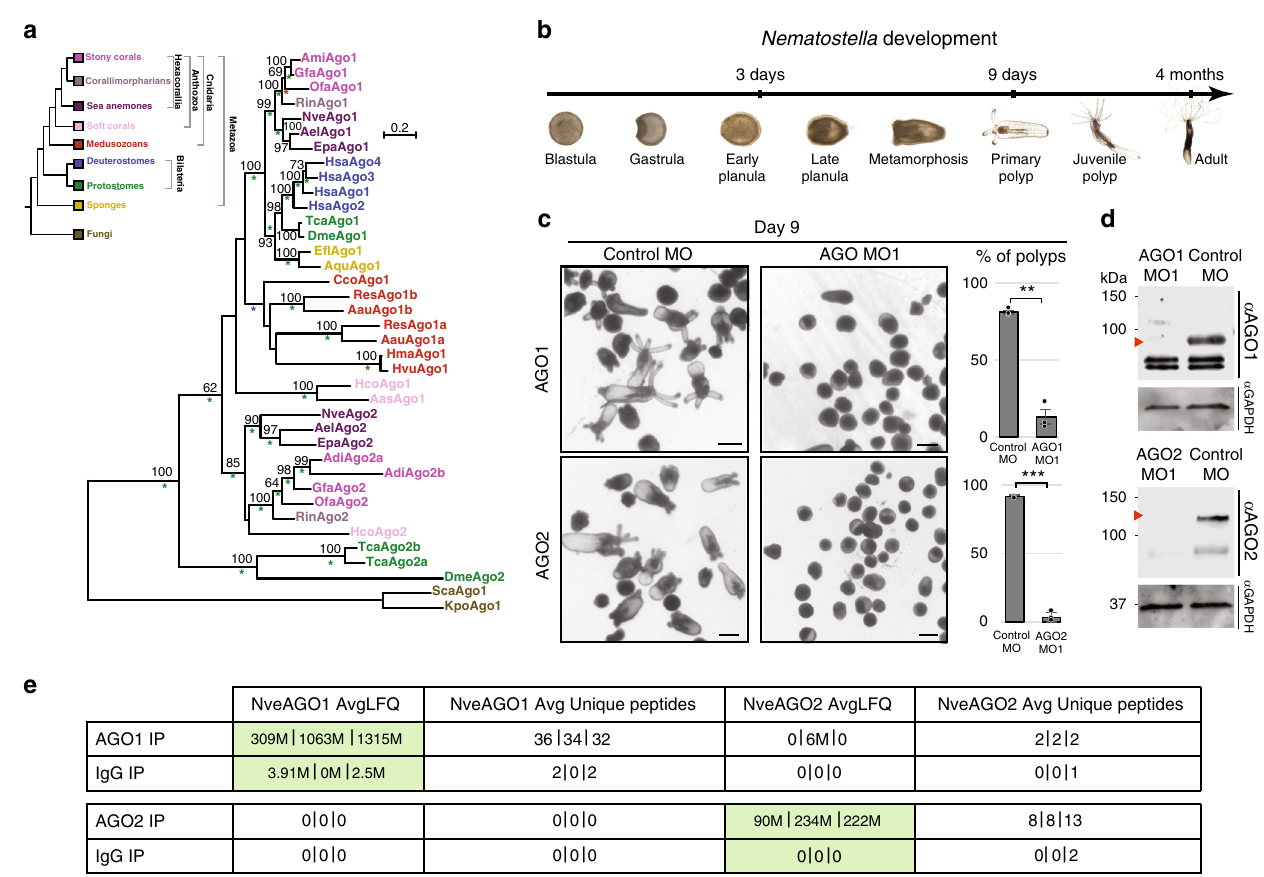
Fig. 1 The hexacorallian AGO duplication, and its importance for Nematostella development. a A phylogenetic relationship of metazoan AGOs. The tree was constructed with the LG model ( + I, + G). Bootstrap support values above 50% are indicated above branches. Posterior probability values of a Bayesian tree of the same topology are indicated by asterisks. A green asterisk represents a value of 1.0, blue represents values >0.95 and lower than 1.0 and a value of 0.95 is indicated by a red asterisk. The tree was rooted by the AGOs of the fungi Saccharomyces castellii (Sca) and Kluyveromyces polysporus (Kpo). Abbreviations of other species names are: Aas, Acanthogorgia aspera ; Aau, Aurelia aurita ; Ael, Anthopleura elegantissima ; Adi, Acropora digitifera ; Ami, Acropora millepora ; Aqu, Amphimedon queenslandica ; Cco, Craterolophus convolvulus ; Dme, Drosophila melanogaster ; E fl , Ephydatia fl uviatilis ; Epa, Exaiptasia pallida ; Gfa, Galaxea fascicularis ; Hco, Heliopora coerulea ; Hma, Hydra magnipapillata ; Hsa, Homo sapiens ; Hvu, Hydra vulgaris ; Nve, Nematostella vectensis ; Ofa, Orbicella faveolata ; Res, Rhopilema esculentum ; Rin, Rhodactis indosinensis ; Tca, Tribolium castaneum . Protein sequences are available in Supplementary Data 10. b Timeline of Nematostella development. c Animals injected with control MO (left panels) 9 dpf. c Animals injected with NveAGO1 and NveAGO2 MOs (middle upper and lower panels, respectively) 9 dpf. Majority of NveAGO1 and NveAGO2 depleted animals did not reach primary polyp stage (right upper and lower panels, respectively) at 9 dpf, three independent biological replicates. ** P = 0.0069, *** P = 0.0005 (one tailed Students t- test), (Supplementary data 6). Data are presented as mean values + / − SD. Scale bars are 250 μ m. d Western blot validation of knockdowns with NveAGO1 and NveAGO2 custom antibodies on extracts from 3 days old planulae, each blotting experiment was carried out twice independently. e LC-MS/MS analysis on three technical replicates. In NveAGO1 IP, an average of 34 speci fi c peptides corresponding to NveAGO1, yielding an average label-free quanti fi cation (LFQ) value of ~895 million, whereas the control sample incubated with Rabbit IgG rather than α NveAGO1 yielded 1.3 peptides and an average LFQ value of 2.1 million. NveAGO2 IP samples provided an average of 9.6 peptides speci fi c for NveAGO2 and an average LFQ value of ~182 million vs. 0.6 peptides and LFQ of 0 for the IgG control. Green shaded pairs indicate statistical signi fi cance ( P = 0.0003 for NveAGO1, and P = 0.001 for NveAGO2, Statistical analysis was performed using the Perseus statistical package, see “ Methods ”